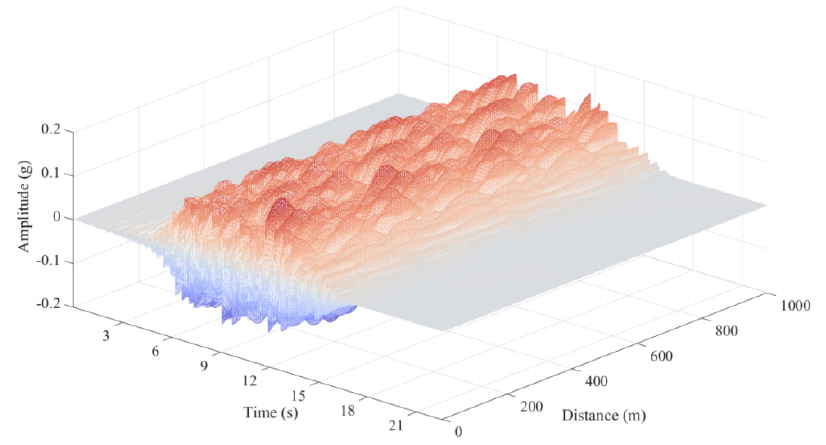
Figure 25. Generated random field of ground motion by the proposed model.